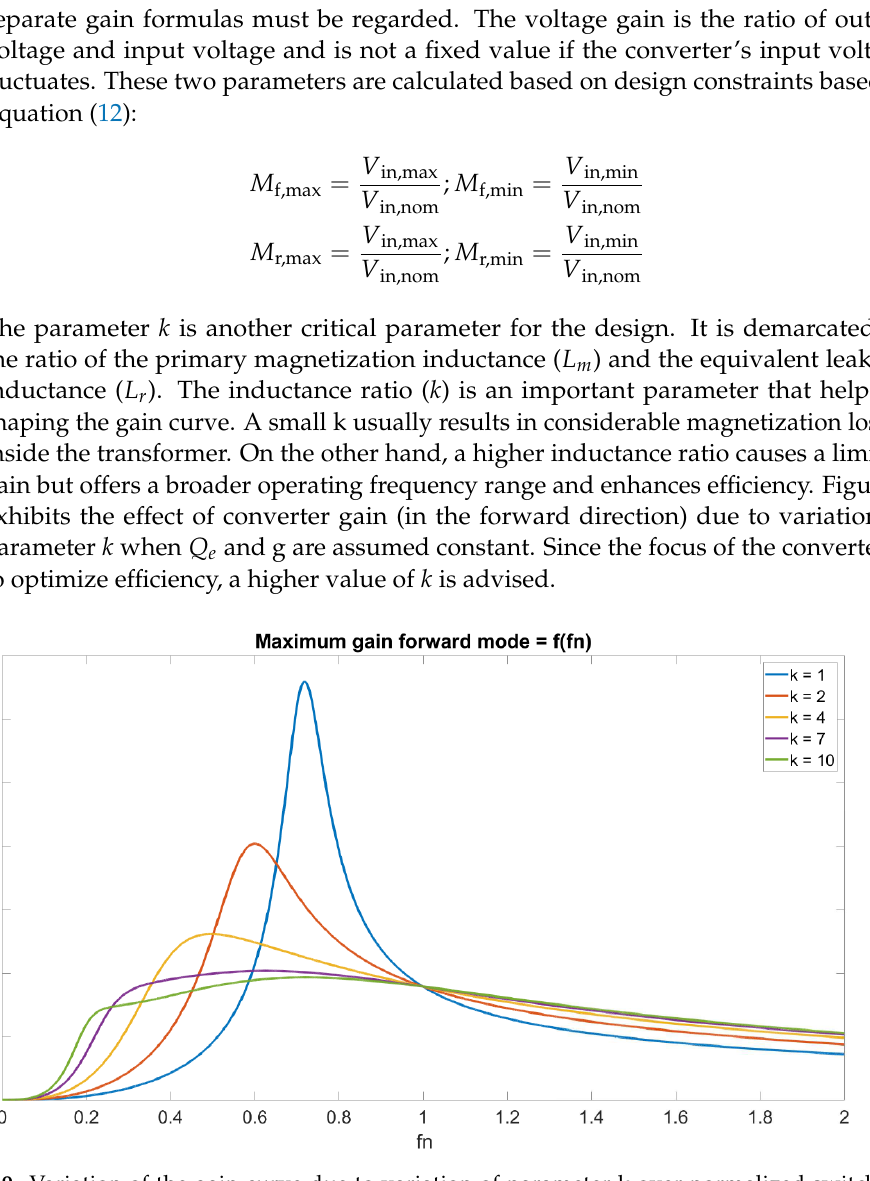
Figure 9. Variation of the gain curve due to variation of parameter k over normalized switching